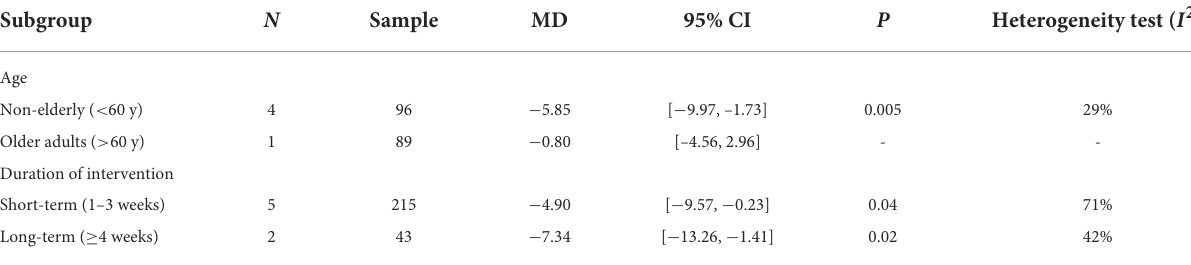
TABLE 2 Subgroup analysis of the efficacy of H-CS light therapy on depressive